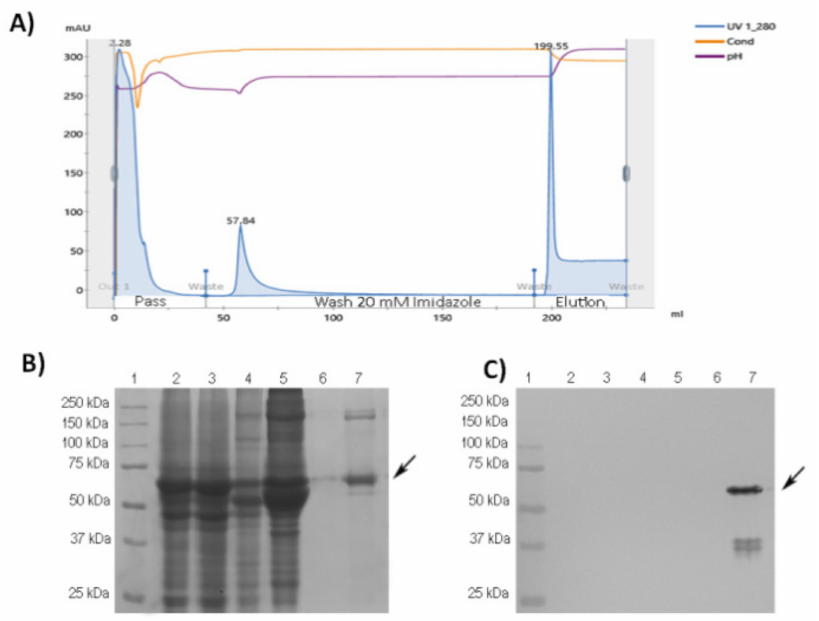
Figure 2. Purification of RBD-CD protein from the culture supernatant of stably transformed HEK293 cells. ( A ) Chromatogram of IMAC purification. Main purification steps are indicated by UV ab- sorbance at 280 nm, pH, and conductivity; they comprise the flow-through after equilibrating the column, a washing step, and elution of purified RBD-CD. ( B ) Coomassie Blue stained 12% SDS- PAGE gel under reducing conditions. ( C ) Western blotting using anti-His tail antibody 1:2000. Lane 1: molecular weight marker, lane 2: initial sample, lane 3: material not bound to the matrix (column flow-through), lanes 4 and 5: 20 mM imidazole wash, lanes 6 and 7: elution at 250 mM imidazole. The arrow indicates the target